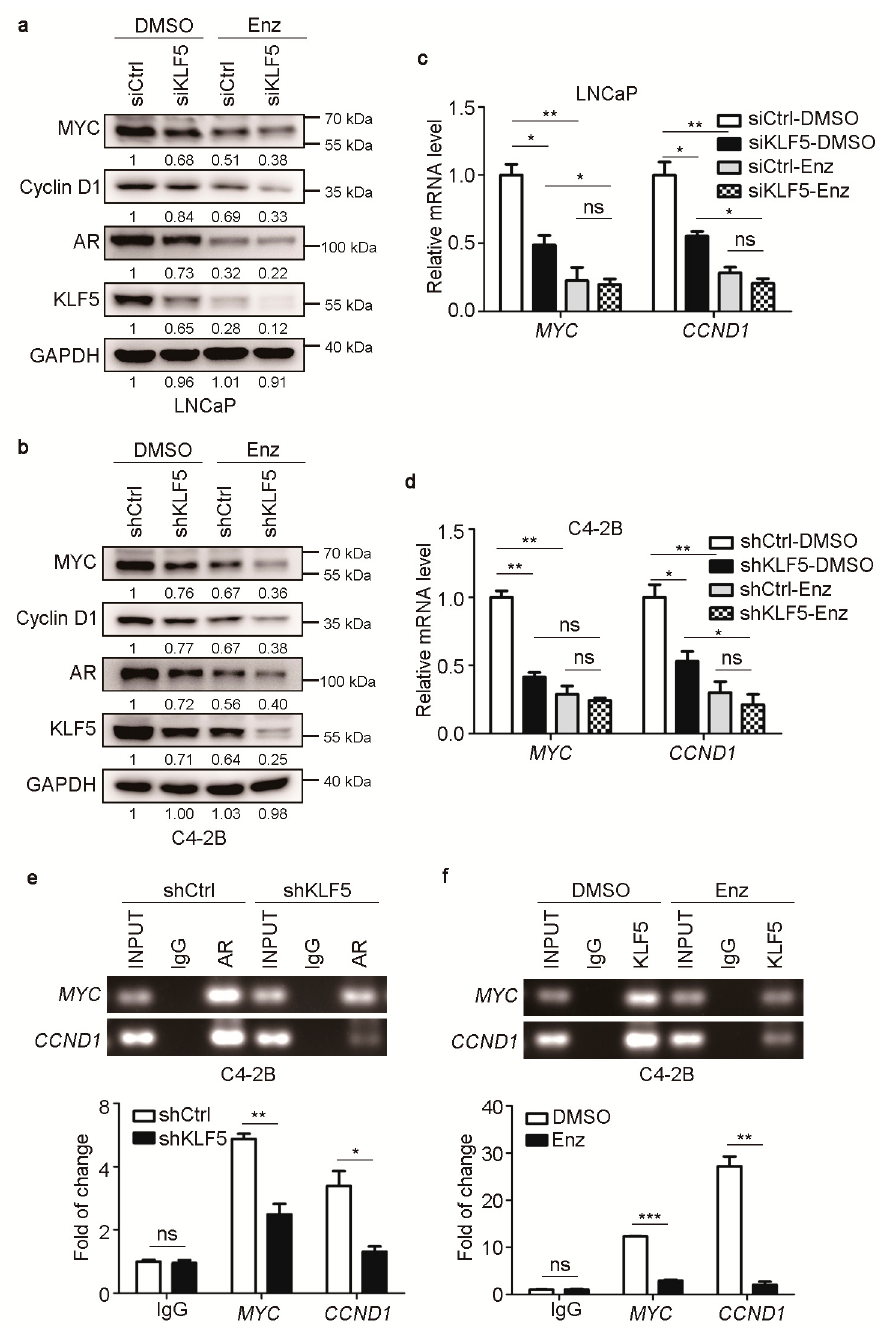
Figure 5. Knockdown of KLF5 attenuates AR-mediated expression of MYC and cyclin D1 in androgen-responsive PCa cells. ( a – d ) RNAi-mediated KLF5 silencing attenuated R1881-promoted expression of cyclin D1 and MYC in LNCaP (a) and C4-2B (b) cells, as detected by western blotting for protein (a, b) and by real-time qPCR for mRNA (c, d). One group of cells were treated with 10 µ M enzalutamide for 72 h. ( e ) Binding of AR to the promoters of MYC and CCND1 was detected by ChIP and PCR (top) or real-time qPCR (bottom) in C4-2B cells expressing shRNAs against KLF5 (shKLF5) and control (shCtrl). ( f ) Binding of KLF5 to the promoters of MYC and CCND1 was detected by ChIP and PCR (top) or real-time qPCR (bottom) in C4-2B cells treated with or without enzalutamide (10 µ M, 24 h). ns, not significant; *, p < 0.05; **, p < 0.01; *** p < 0.001. 2.6. KLF5 Is Crucial for Androgen/AR to Promote Cell Proliferation and Tumor Growth in PCa Cells